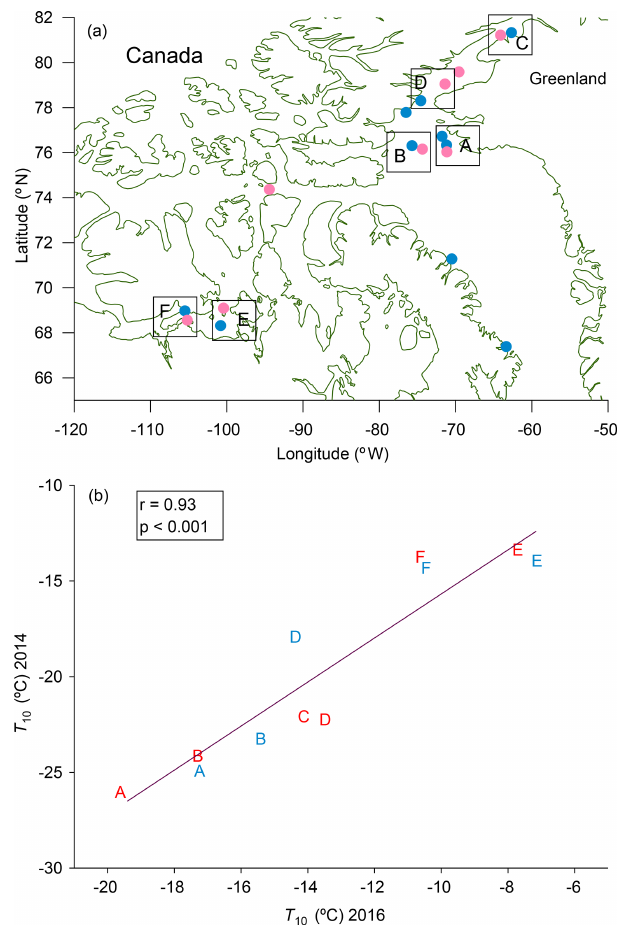
Figure 5. (a) Map showing regions of similar sampling locations in 2014 (pink) and in 2016 (blue). Sampling sites in 2014 that were near sampling sites in 2016 were paired together (indicated with boxes in the figure) and assigned letters A–F. Although there are two stations in box A for 2016, we only used data for the station that was closest to the one in 2014. (b) Relationships between T 10 values for microlayer and bulk seawater samples in 2014 and 2016 for similar sampling locations. The letters plotted in (b) indicate the locations in (a) . Red letters represent bulk seawater data, and blue letters represent microlayer data. Only freezing data that were at warmer temperatures than the field blanks are included.